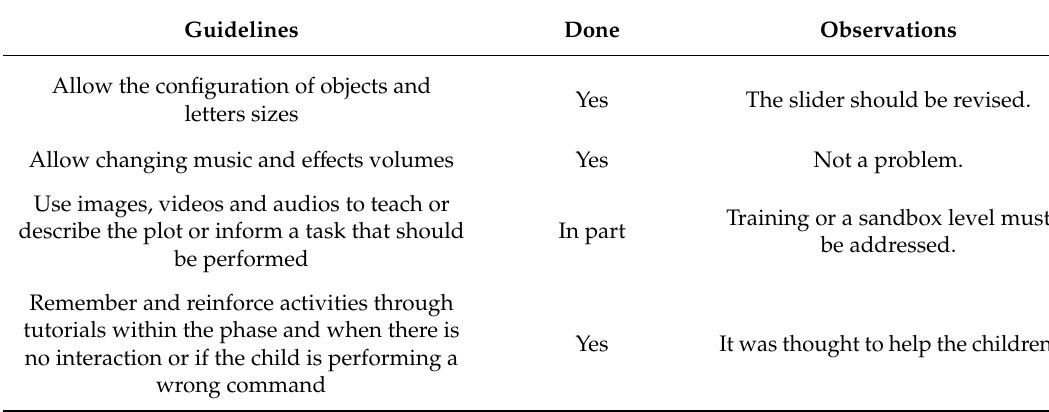
Table 14. Analysis of the guidelines from Nascimento et al.